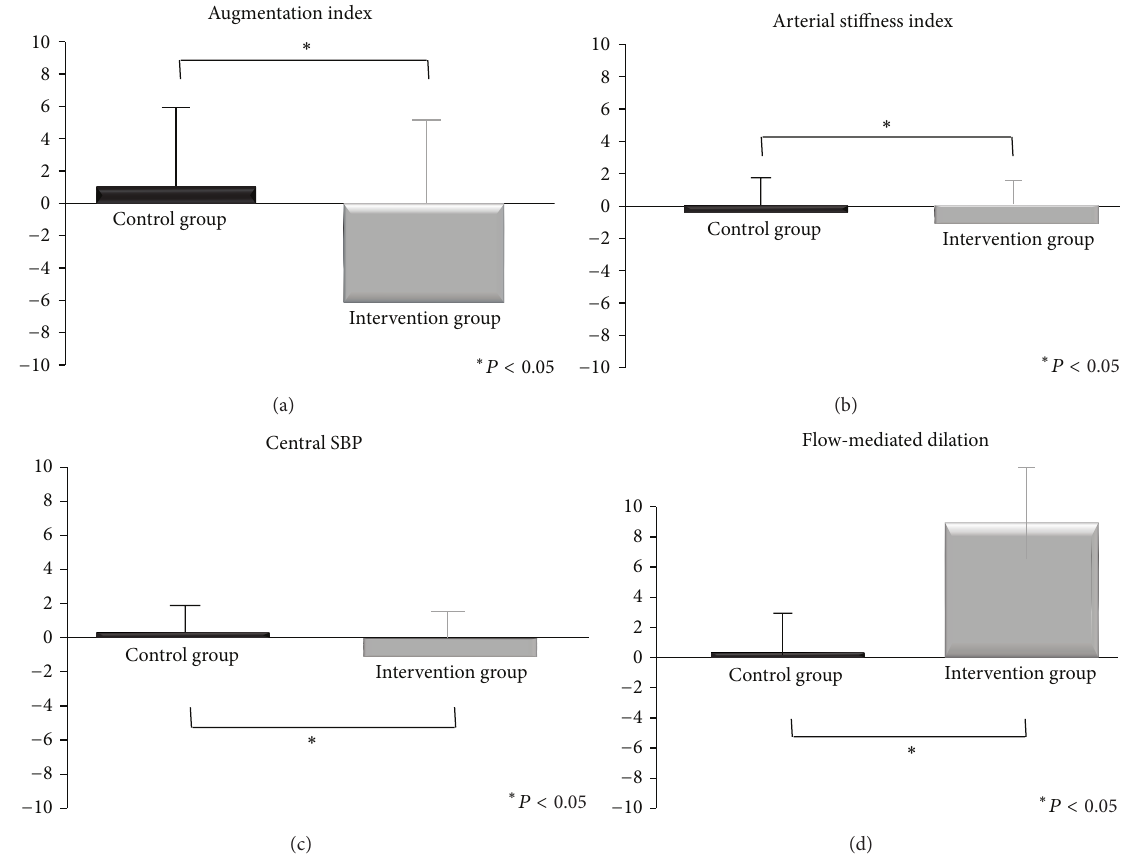
Figure 2: Differences in central hemodynamic parameters after 30 days of chocolate